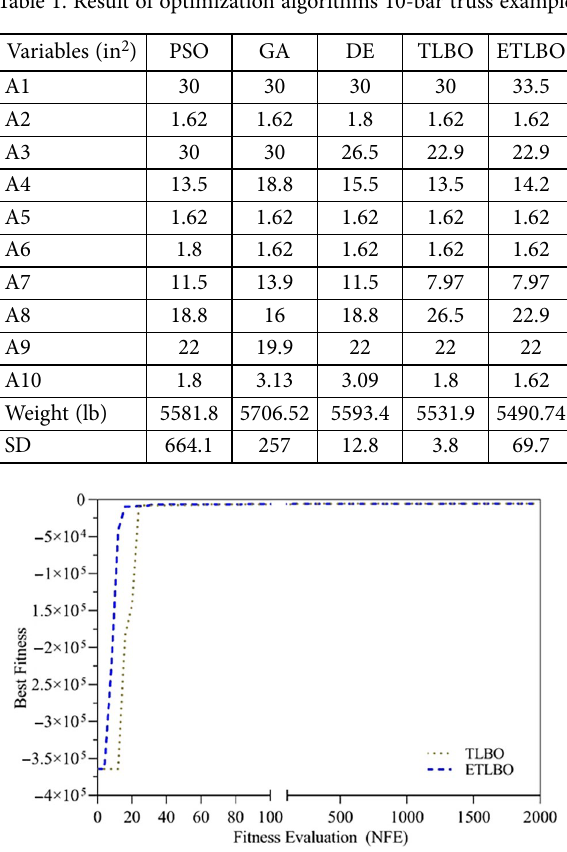
Figure 3. Convergence comparison of ETLBO vs. TLBO for the 10-bar truss